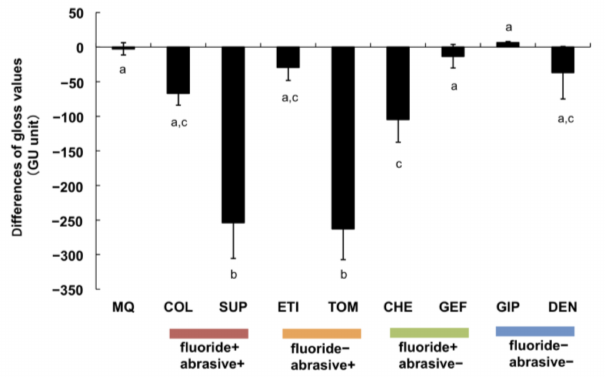
Figure 4. Influence of brushing with toothpastes or MQ on titanium gloss. The gloss values represent the variations with the values of the control sample. Independent experiments were repeated three times. Data represent the means ± SD of triplicate experiments. The different letters among the samples indicate a statistically significant difference ( p <